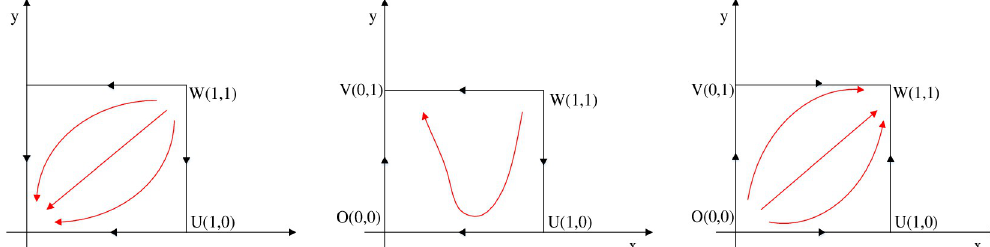
Fig 5. The evolution phase diagram of manufacturing enterprise path selection under the carbon tax(IV), (V) and (VI).